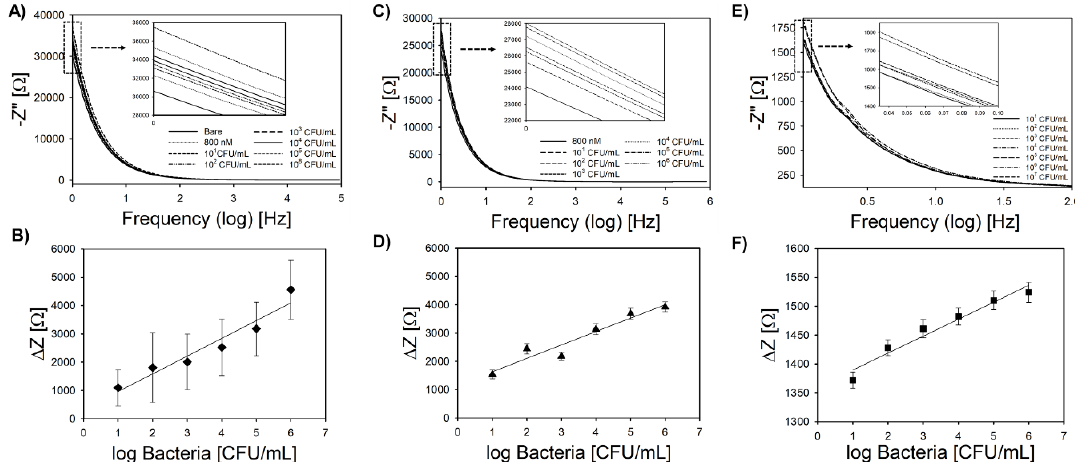
Figure 4. ( A ) Representative Bode plot for L. innocua in phosphate buffer saline (PBS) using a laboratory potentiostat under controlled conditions (inset shows linear region between 1 to 1.2 Hz). ( B ) Calibration plot using change in impedance at a cutoff frequency of 1 Hz. ( C ) Representative Bode plot for L. monocytogenes in in vegetable broth using a laboratory potentiostat under controlled conditions (inset shows linear region between 1 and 1.2 Hz). ( D ) Calibration plot in vegetable broth using a change in impedance at a cutoff frequency of 1 Hz. ( E ) Representative Bode plot for L. innocua in PBS using a smartphone-based potentiostat in hydroponic media (inset shows linear region between 10 and 100 MHz). ( F ) Calibration plot using change in impedance at a cutoff frequency of 0.03 Hz. All error bars represent standard deviation of the arithmetic mean (n = 3).